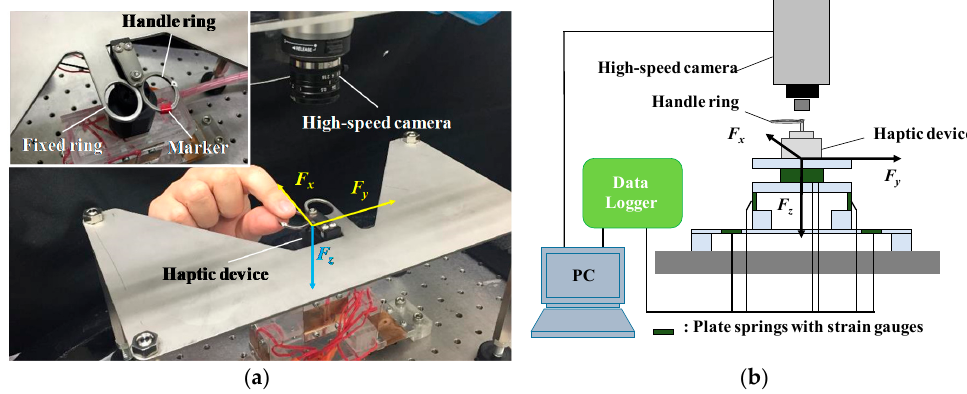
Figure 3. Photograph ( a ) and schema ( b ) of a scissors-type haptic device and mechanical evaluation system.